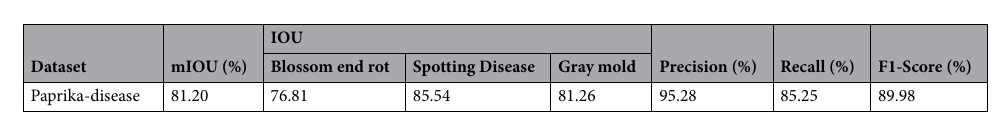
Table 10. Quantitative Results on the Paprika-Disease dataset having multiple